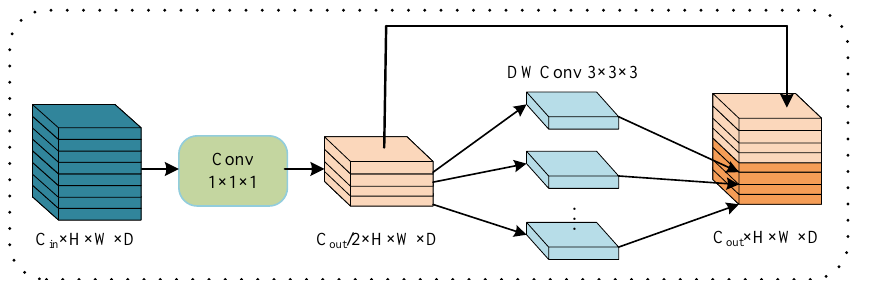
Figure 4. The dimensionality reduction method in LMRF module. This method can achieve the same function as 1 × 1 × 1 convolution and reduce feature